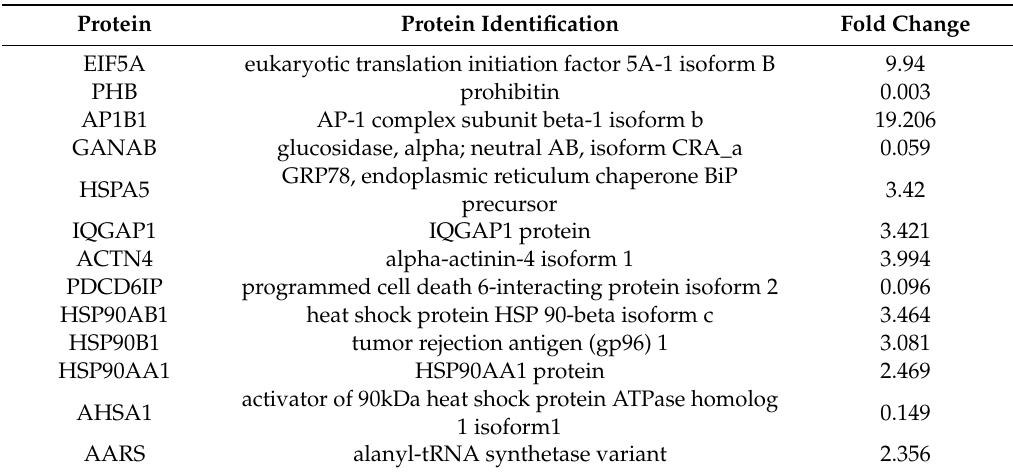
Table 2. Proteins identified by 2D gel electrophoresis and peptide mass fingerprinting (PMF)